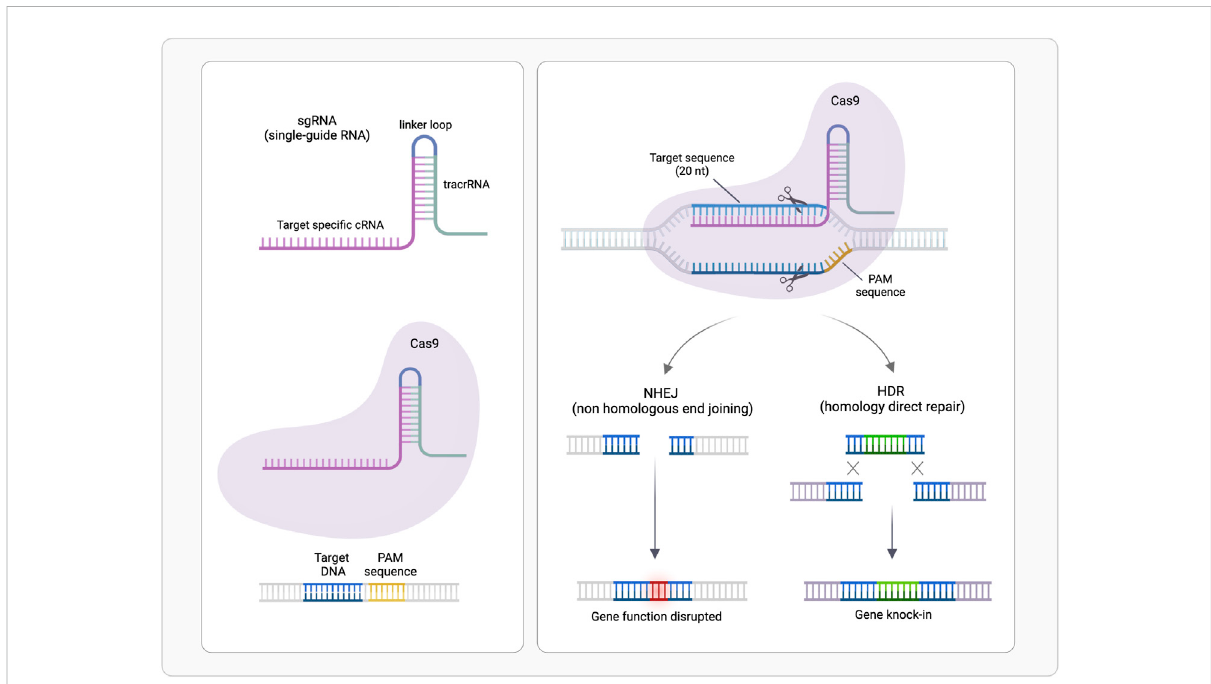
FIGURE 2 CRISPR/Cas9-mediated genome editing. A single guide RNA (sgRNA), consisting of a crRNA sequence that is speci fi c to the DNA target, and a tracrRNA directs the Cas9 protein to a complementary sequence in the genome followed by a protospacer adjacent motif (PAM) where Cas9 will induce a double-stranded DNA cleavage. Repair after the DNA cut may occur via non-homologous end joining (NHEJ), leading to a random insertion/deletion of DNA, or homology directed repair (HDR) in the presence of a DNA repair template, which can be exploited to introduce precise genetic modi fi cations or exogenous sequences. (Realized with